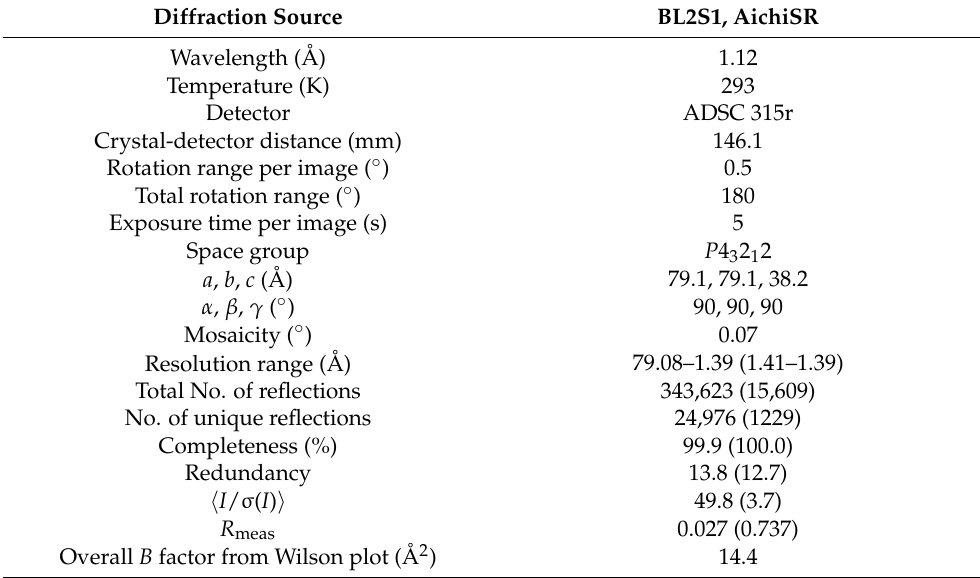
Table 4. Data collection and processing of lysozyme